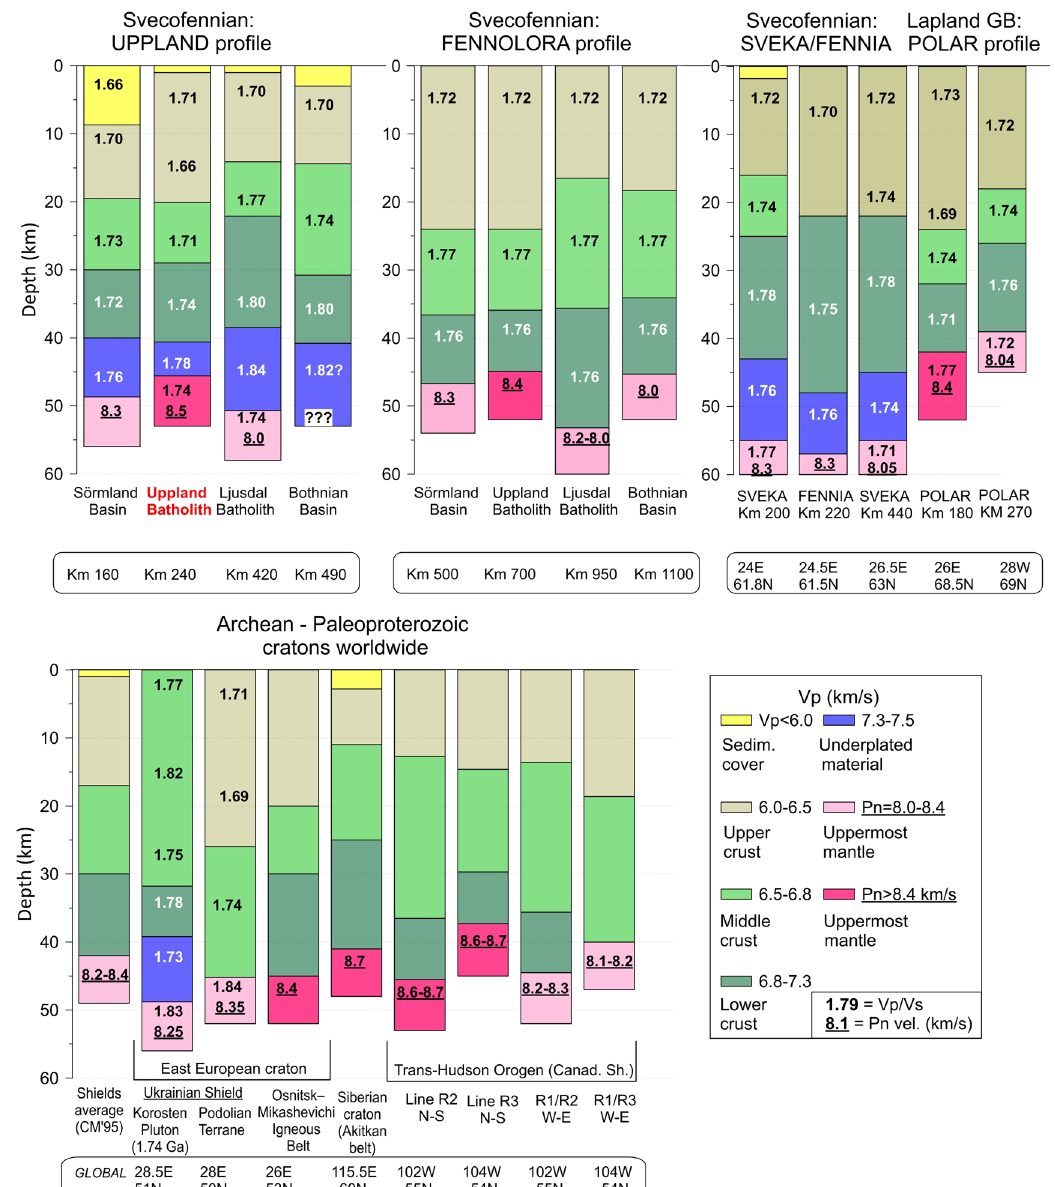
Fig. 3 Vertical crustal seismic P-wave velocity sections. Sections for the Svecofennian province along the new UPPLAND seismic pro fi le and the FENNOLORA pro fi le (after ref. 48 ; Pn velocity from ref. 47 ) compared with sections for other cratonic regions with a high Pn velocity (>8.4 km/s): Baltic Shield 28,40 , East European Craton 55 , Siberian craton 41 , and Trans-Hudson orogen of the Canadian Shield. Global average for shields and platforms 11 (CM ’ 95) is shown for comparison. Numbers — Vp/Vs ratio, where determined; underlined numbers — Pn velocity (km/s). Text in boxes — pro fi le distance for the two Svecofennian pro fi les and coordinates for other